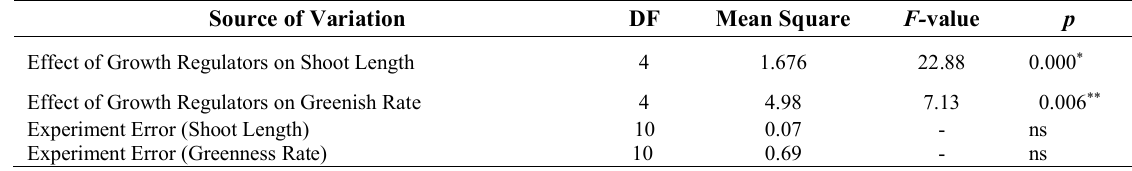
Table 4. Analysis of variance of different cytokines effects on growth factors.